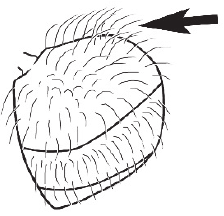
Australia, apparently sympatric with above species) ( JDM 899 ) (Fig. 43a–g) ... ........................................................................................................... mjobergi 37 Gaster with curved erect setae, semi-erect setae and a few decumbent setae only, genuine appressed setae lacking; body generally strongly sculptured and hirsute, antennal scapes and legs with whorls of many fine, straight setae (several hairy members of the M . fieldi complex) ......................................